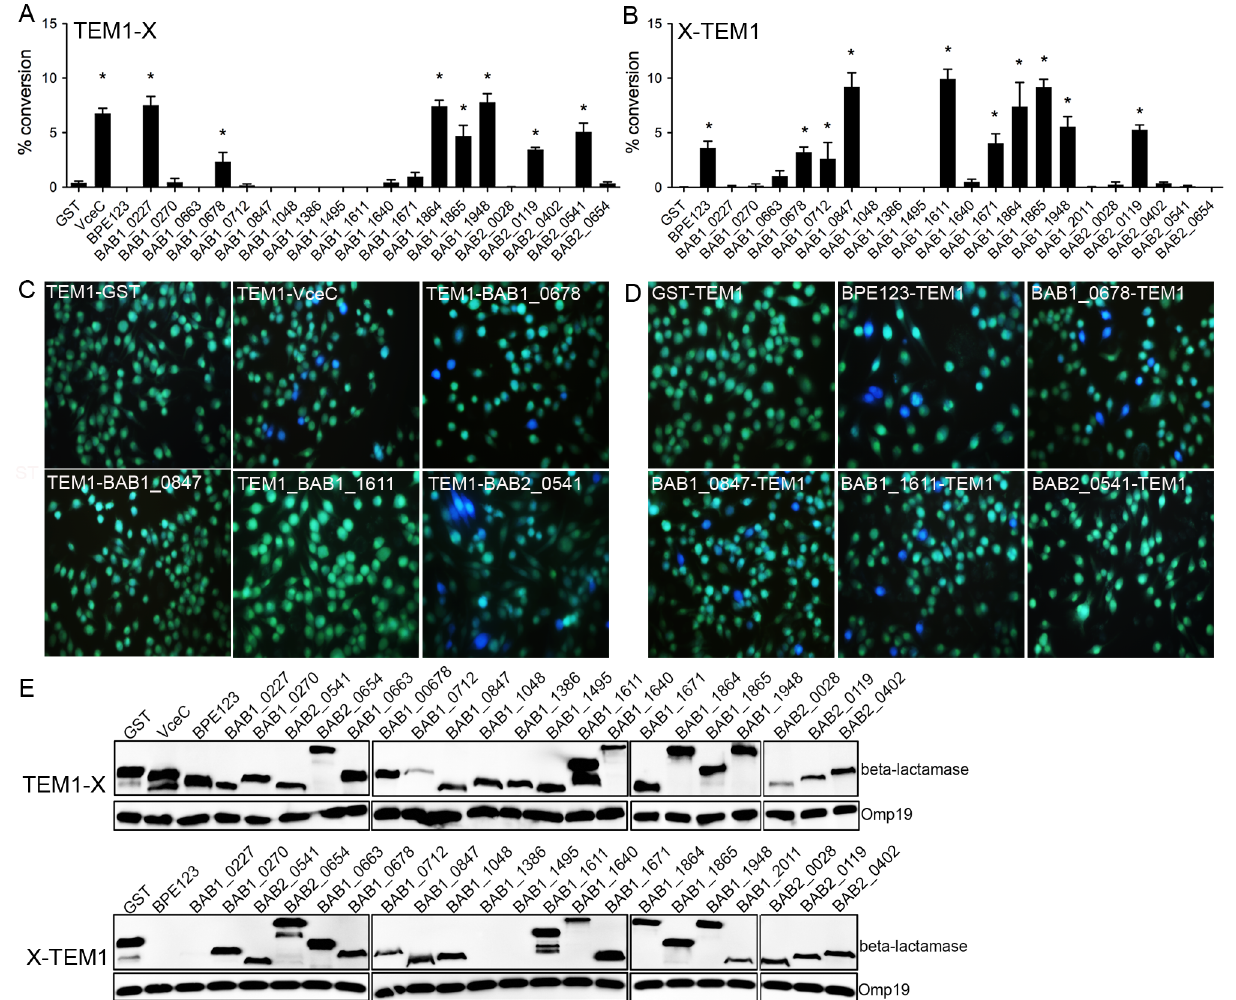
Figure 1. Translocation of Brucella putative effector proteins into J774A.1 cells. (A and B) Quantification of the translocation of N- terminally- (A) or C-terminally- (B) TEM1-tagged Brucella proteins. The cytosolic translocation of b -lactamase by B. abortus strain 2308 expressing the different TEM1 fusion proteins was assessed by fluorescence microscopy in J774.A1 macrophages after 16 h of infection. Cells from ten independent random fields were counted and the percentage of blue cells calculated. Results shown are the mean 6 SD of three independent experiments. TEM1- GST and GST-TEM1 were used as negative controls (green fluorescence) and TEM1-VceC as a positive control (blue fluorescence). (C and D) Representative fluorescence micrographs from individual assay wells showing control proteins (GST and VceC) and selected TEM1 fusion proteins tagged at either the N-terminus (C) or C-terminus (D). (E) Western blot analysis showing expression of TEM-1 fusions. Bacterial lysates from B. abortus 2308 strain expressing TEM-1 fusion proteins were resolved using SDS-PAGE and subjected to Western blot analysis with anti- b -lactamase TEM-1 antibody. Detection of Brucella Omp19 was used as a loading control.